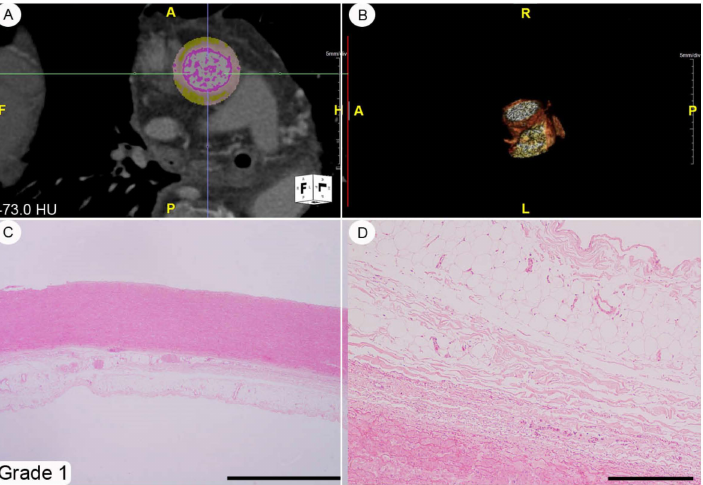
Figure 2. Adventitial fibrosis, grade 1. This index case refers to a 72 year-old male patient suffering from AA aneurysm characterized by an attenuation histogram of peri-vascular adipose tissue of mean − 73 HU (CTA shown in ( A , B )). The histopathological correlates of CTA findings show an aortic tunica media thickness within the normal ranges ( C ) and an initial collagen fiber deposition affecting the adipose tissue of the adventitial and peri-adventitial layers ( D ) with focal signs of consequent adipocyte hypotrophy/atrophy ( D ). Staining. ( C , D ): hematoxylin-eosin. Original magnifications. ( C ): × 2 (bar is 1 mm), ( D ): × 10 (bar is 250